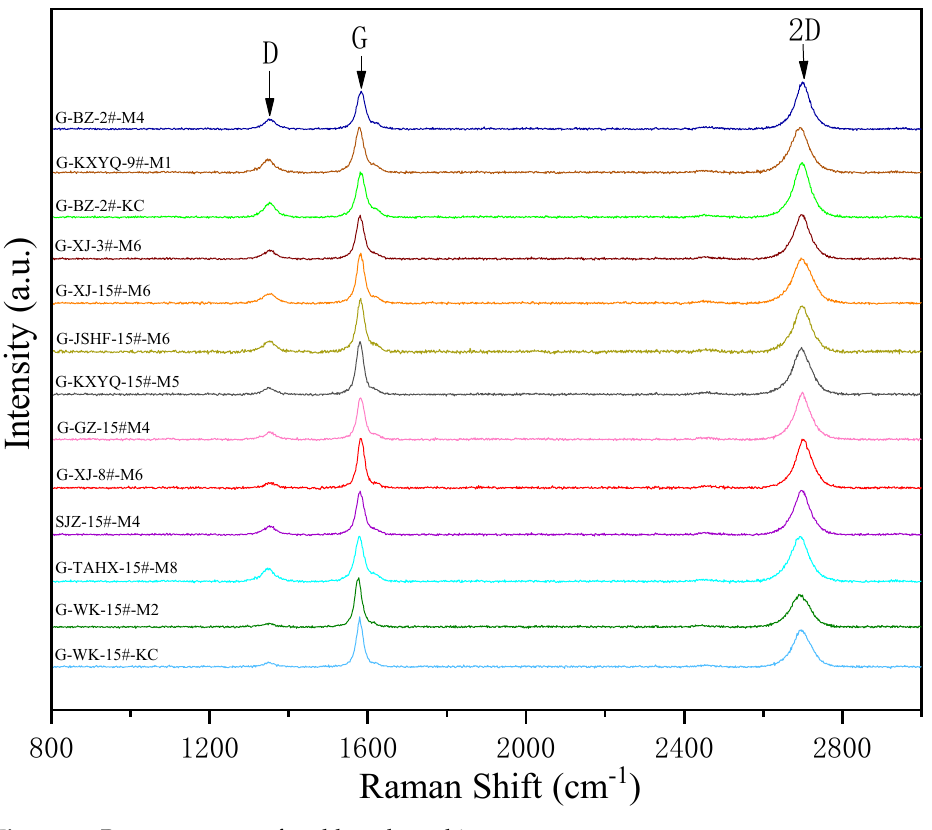
Figure 11. Raman patterns of coal-based graphite. Table 7. Raman parameters of coal-based